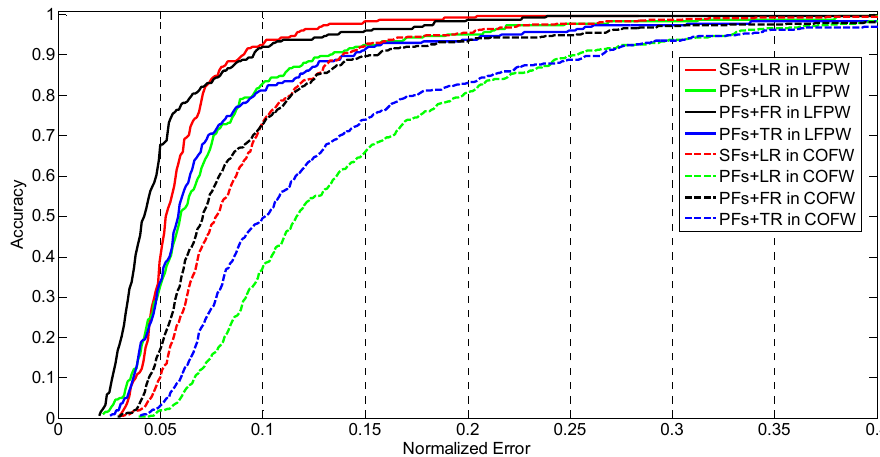
Figure 1. The comparison of CED curves on LFPW and COFW datasets for different combinations of feature mapping function and regression function.